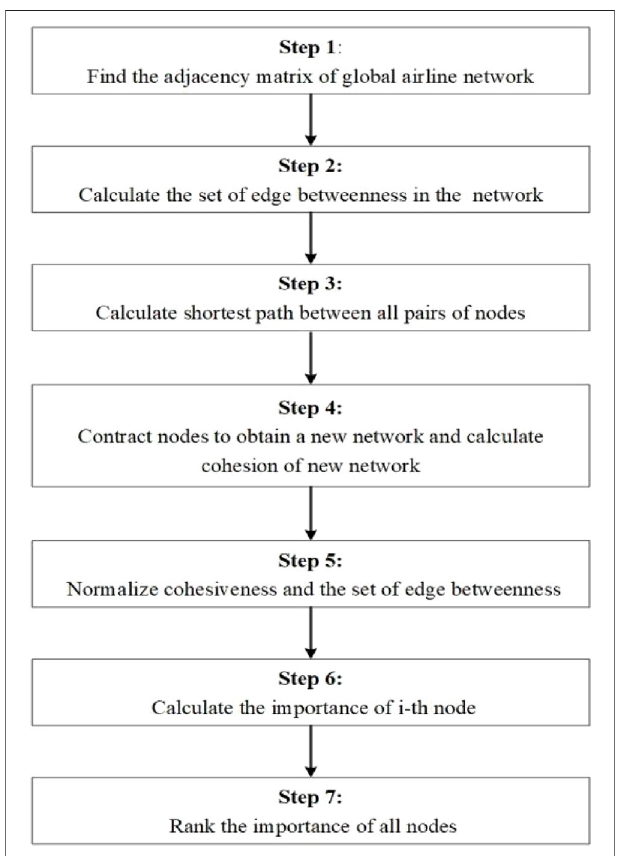
FIGURE 2 | Flow diagram of the solution of the algorithm.